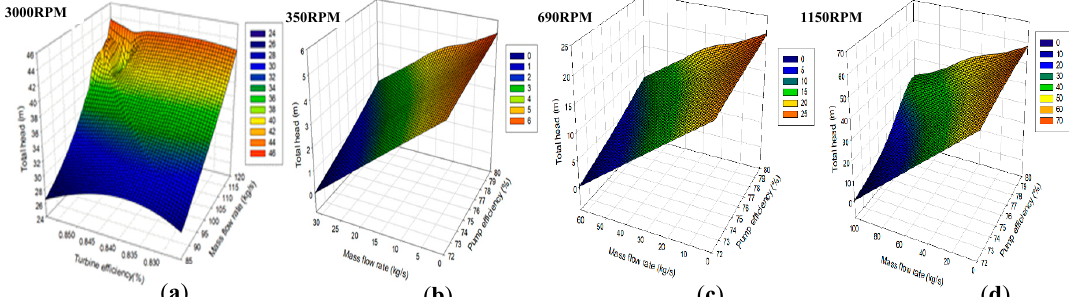
Figure 4. The characteristics of the power and head variation with the flow rate and efficiency of the applied turbine and working fluid pump: ( a ) turbine; ( b ) 350 RPM pump; ( c ) 690 RPM pump; and ( d ) 1150 RPM pump .